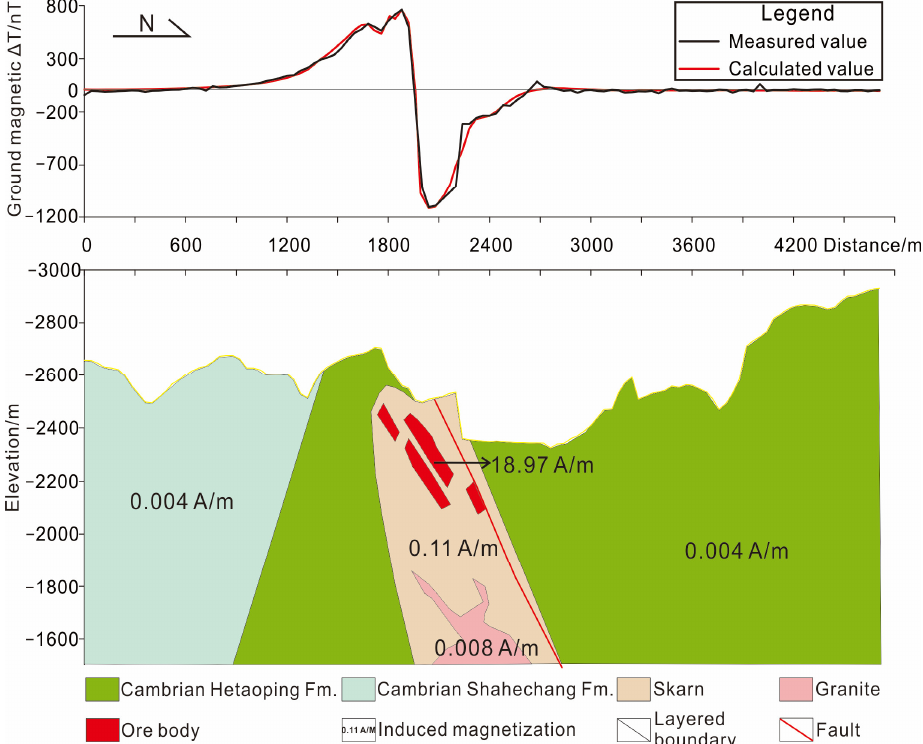
Figure 6. The 2.5D inversion results of the section of Line AB. M i = κ × ( T /μ 0 ), where M i is induced magnetization, κ is the magnetic susceptibility, and μ 0 is permeability of vacuum and is set to a constant 1.256637 × 10 3 nT·m/A. Moreover, geomagnetic field intensity T in the Hetaoping area is approximately 47,679 nT.